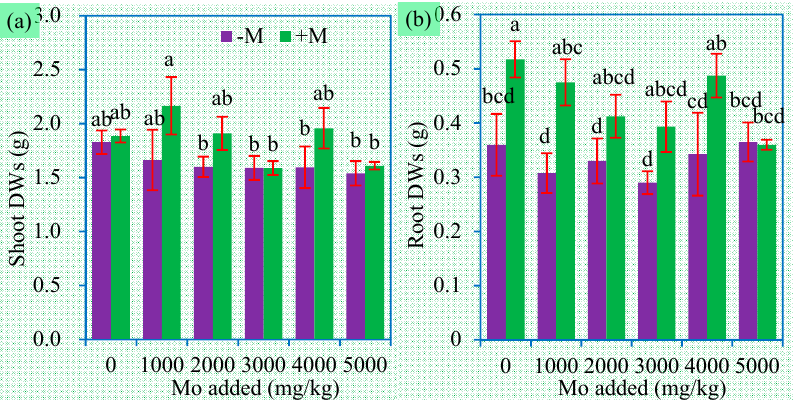
Figure 2. Shoot ( a ) and root ( b ) DWs (mean ± SE, n = 4) of sweet sorghum exposed to different concentrations of Mo. -M and +M represent non-AM inoculation and inoculation with Claroideoglomus etunicatum BEG168, respectively. Different letters over the bar represent significant differences between the means among different treatments using one-way ANOVA followed by Duncan’s multiple range test ( p < 0.05). Two-way ANOVA results for shoot DWs: AM inoculation: F = 4.6*, Mo: F = 1.1 ns, AM×Mo: F = 0.5 ns; two-way ANOVA results for root DWs: AM inoculation: F = 17.0**, Mo: F = 1.4 ns, AM×Mo: F = 1.0 ns. Significance levels: * p < 0.05; ** p < 0.01; ns non-significant effect.